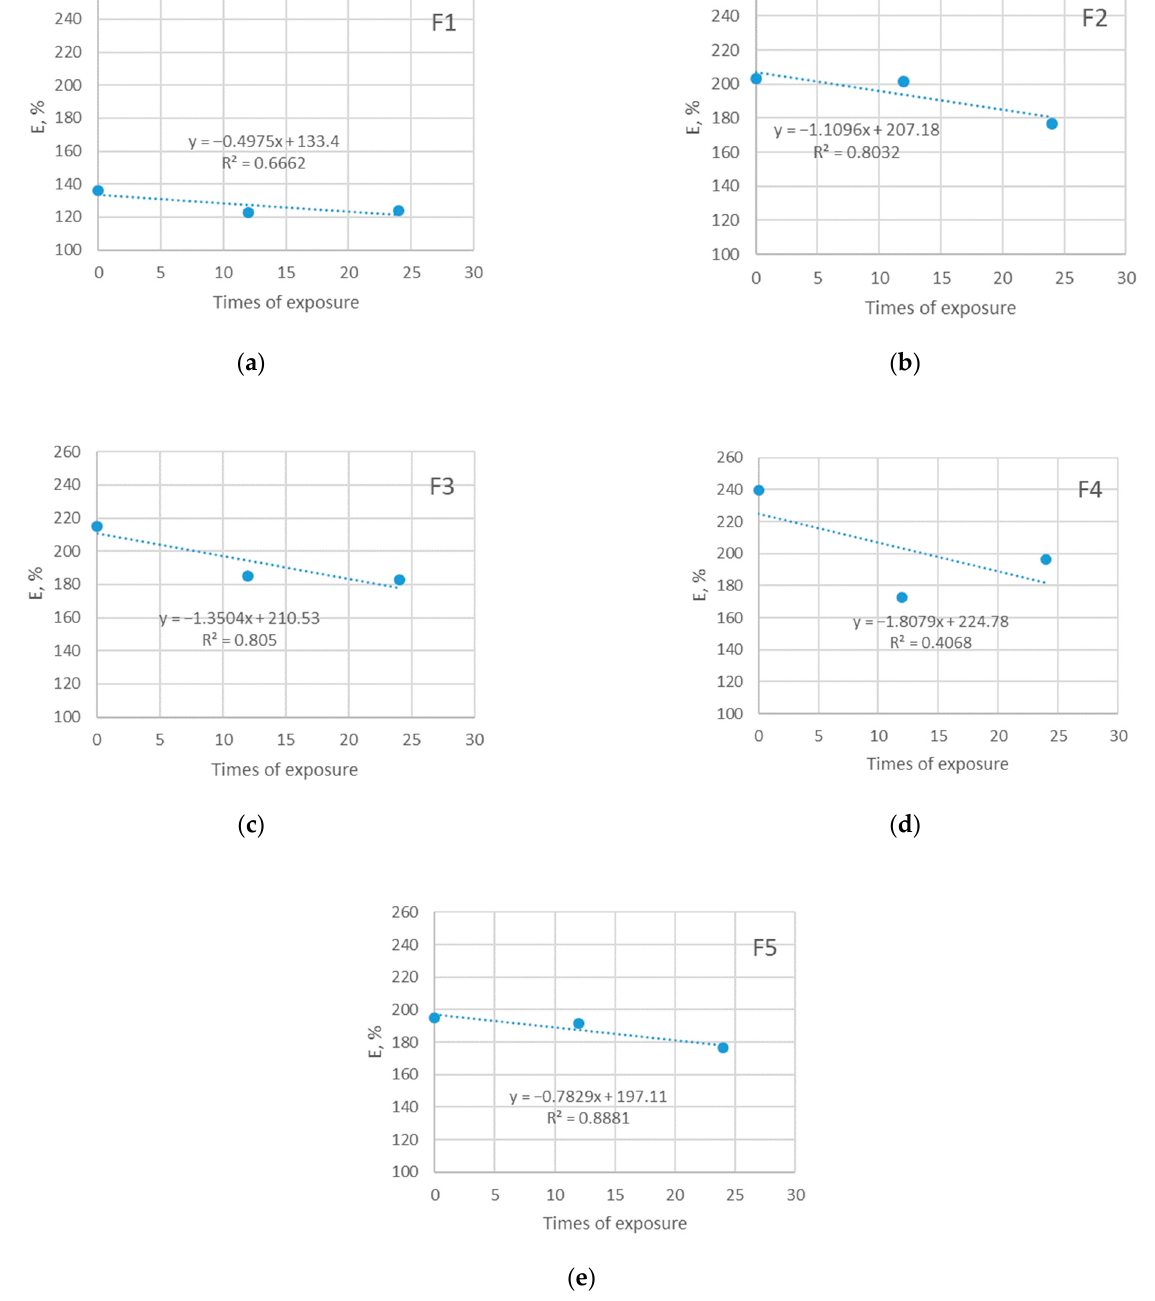
Figure 7. Breaking elongation of five investigated materials exposed to sun: ( a ) F1; ( b ) F2; ( c ) F3; ( d ) F4; ( e ) F5.